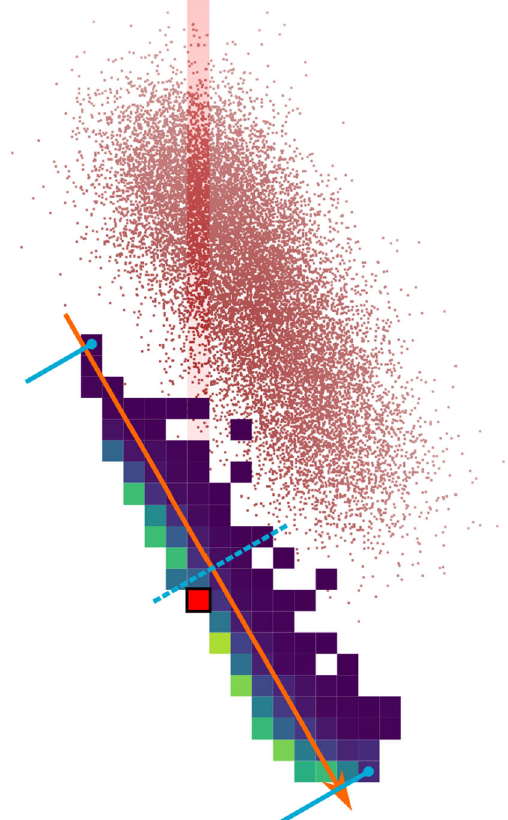
Fig. 13 An illustration of integration effects in the head-charge frac- tion (HCF) calculation. Amplified charges (red dots) and the digitized track (2D histogram) are shown in an x − z projection for a 400 keV downgoing track with θ = 150 ◦ . The majority of the charge is in the upper half of the charge cloud (further from the readout plane). How- ever, when the detected track is split into two halves (blue lines), the lower half includes significantly more charge. To illustrate why, a sin- gle hit is highlighted in red with a black border. This hit contains all the charge integrated in a rectangular column indicated with pale red. Although the hit is assigned to the lower half based on its position rel- ative to the track endpoints, most of its charge comes from the upper half of the charge cloud. This track is therefore assigned the incorrect head-tail using the HCF